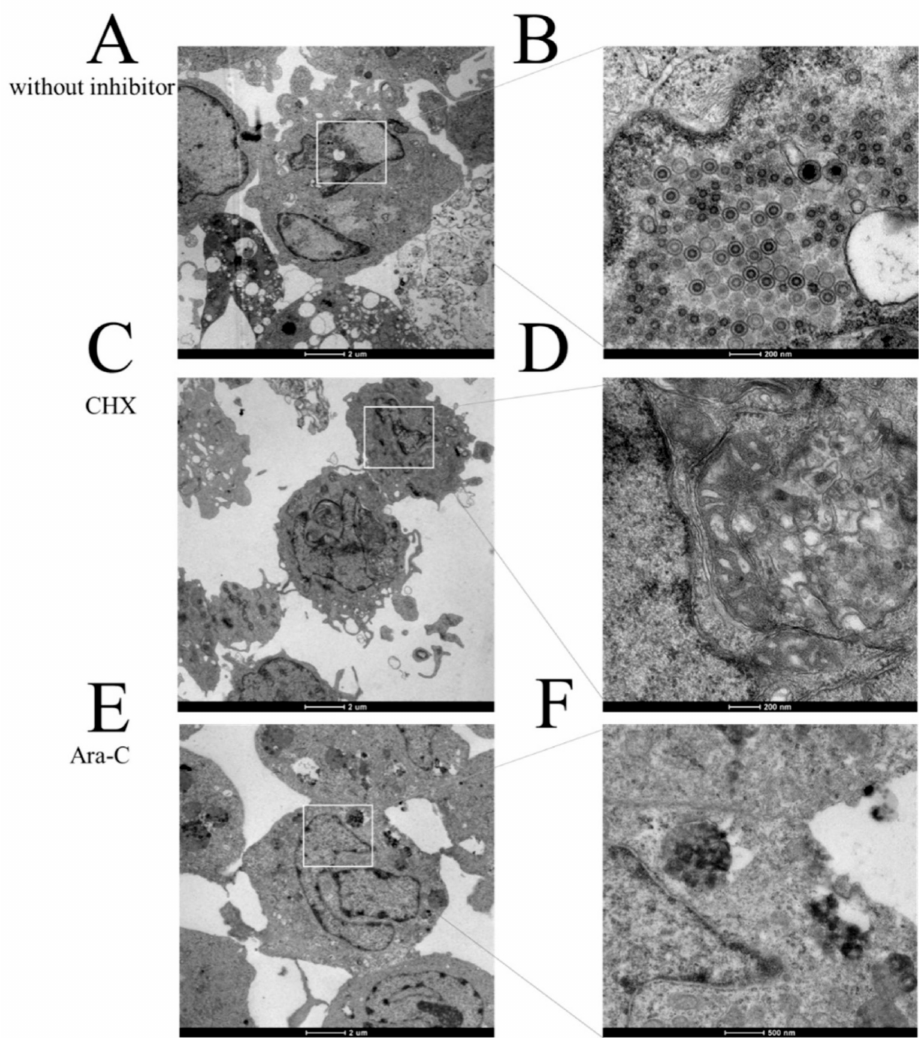
Figure 5. Action of CHX and Ara-C on progeny virus production. ( A , B ) Transmission electron microscopy image of the uptake of CyHV-2 into RyuF-2 cells (including a magnified image of a region of the first panel). ( C , D ) Transmission electron microscopy image of the uptake of CyHV-2 into RyuF-2 cells in the presence of CHX (including a magnified image of a region of the first panel). ( E , F ) Transmission electron microscopy image of the uptake of CyHV-2 into RyuF-2 cells in the presence of Ara-C (including a magnified image of a region of the first